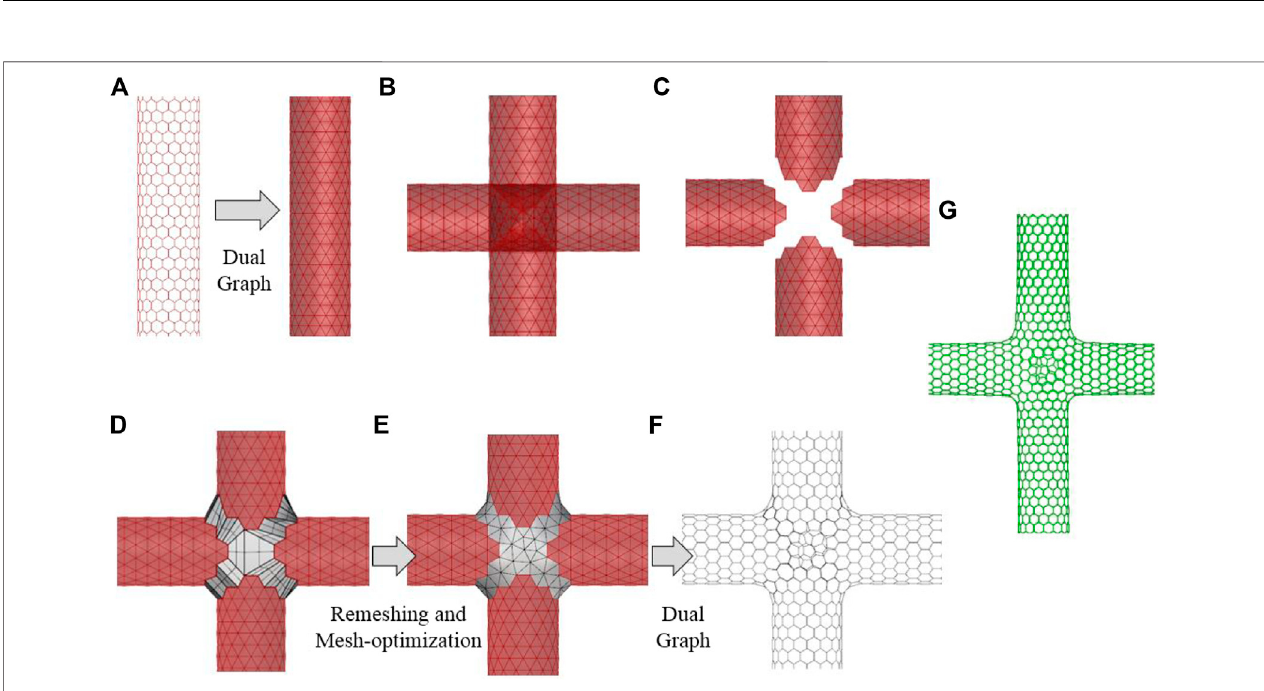
FIGURE 4 | Procedure for constructing orthogonal 4T-Junction. (A) Dual triangular mesh of (16,0) nanotubes. (B) Right angle interconnection of the triangular mesh. (C) Removalofmeshverticescloserthan2.45Å (D) Stitchingthevoidsurfacewithrandomlygeneratedmesh. (E) Remeshingandmeshoptimizationwithtargetlength 2.45 Å. (F) Dual of the fi nal triangular mesh. (G) Atomistic model of 4T-Junction after molecular minimization (MM).